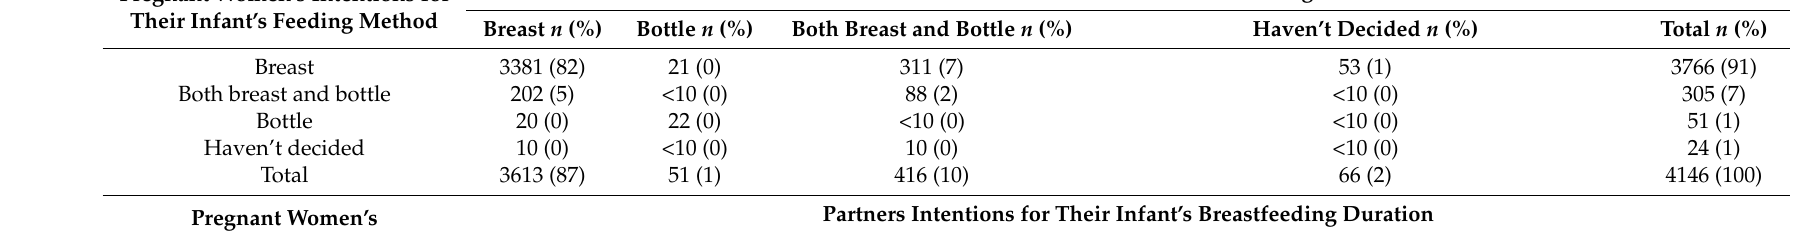
Table 2. Agreement between pregnant women and their partners about their intentions for their infant’s feeding method a and their intentions for their infant’s breastfeeding duration b . Pregnant Women’s Intentions